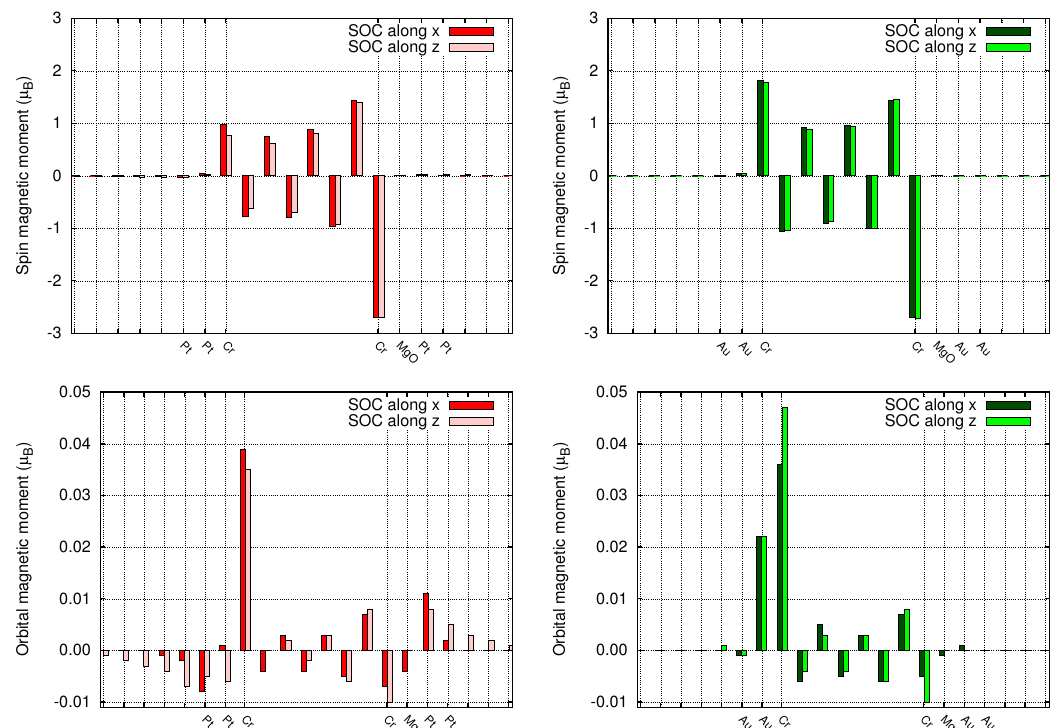
Figure 9. Spin ( top panels ) and Orbital ( bottom panels ) magnetic moments of the asymmetric devices, in presence of spin-orbit. Left panels: Pt/Cr/MgO/Pt. Right panels: Au/Cr/MgO/Au. The dark red and green bars denote the magnetic moments when the spin moments are oriented parallel to the interface (i.e., transverse to the transport direction). The light red and green bars are for the spins oriented perpendicular to the interface (i.e., parallel to the transport direction).